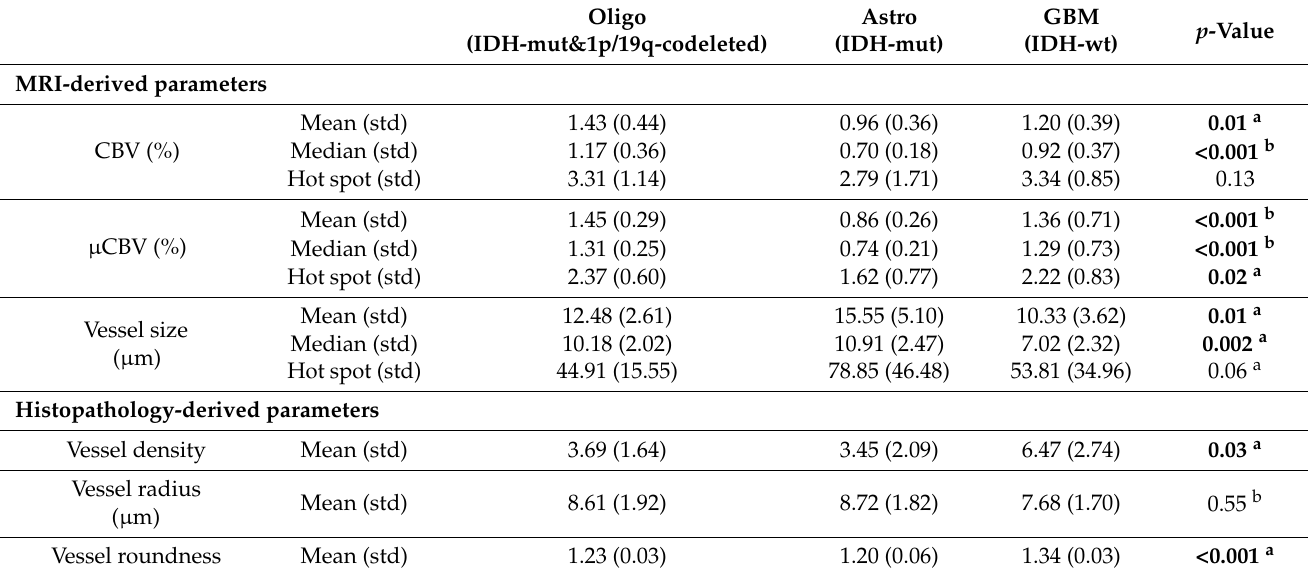
Table 2. Group averages of CBV, µ CBV, and vessel size in the three glioma subtypes: Oligo (IDH- mut&1p/19q-codeleted), Astro (IDH-mut), and GBM (IDH-wt). a : one-way ANOVA test; b : Kruskal– Wallis test. The bold formatting indicates a significant p -value.